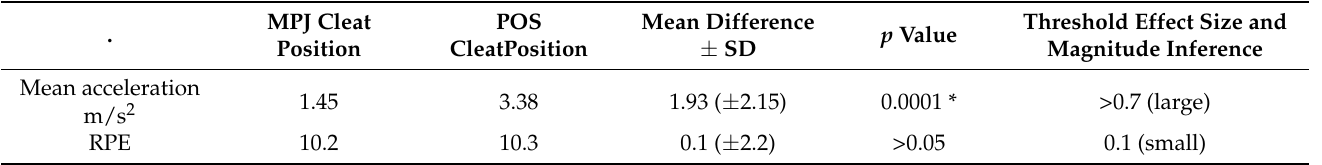
Table 2. Magnitude of mean trunk acceleration (in m/s 2 ) in two cleat positions in 20 km cycling. RPE = ratings of perceived exertion.